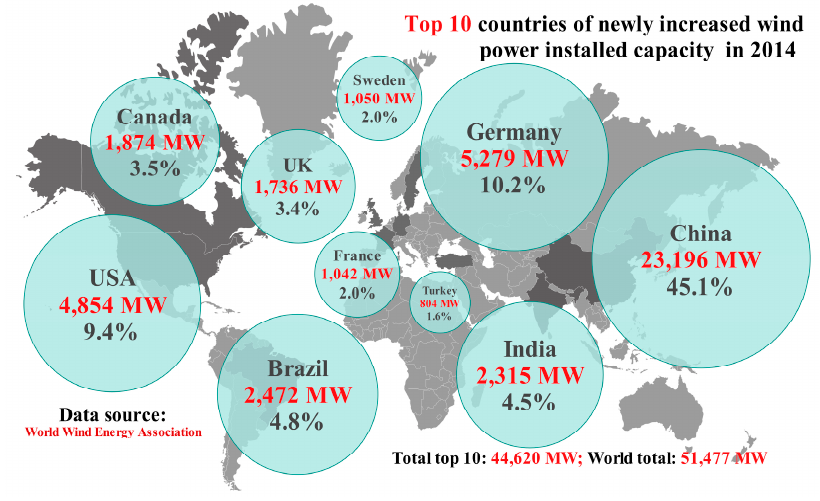
Figure 1. Top 10 countries in cumulative installed wind power capacity in 2014.